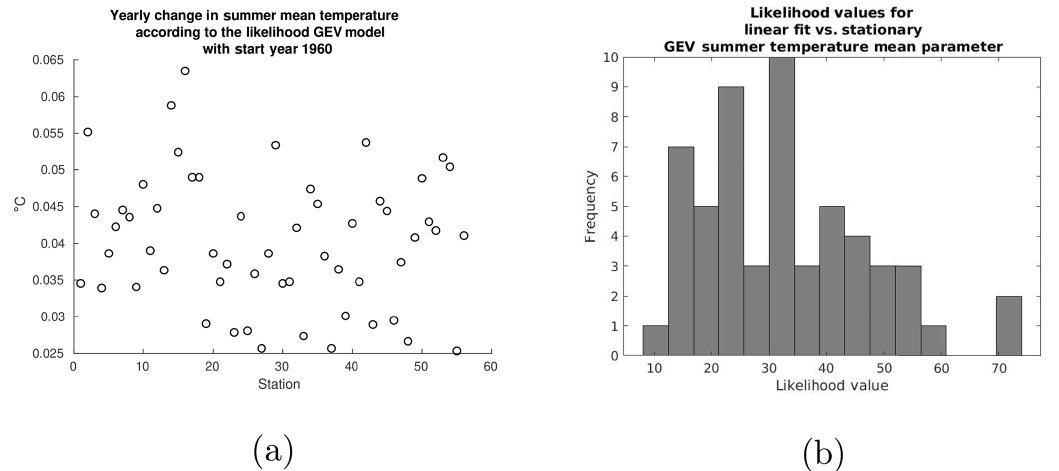
Figure 7. (a) Scatter plot of the yearly change in the temperature mean according to the likelihood GEV model for all stations. (b) Likelihood values comparing the linear fit of the summer temperature mean to that of a stationary mean. All likelihood values surpass the chi-square value of χ 2 (1 , 0 . 05) = 3 .